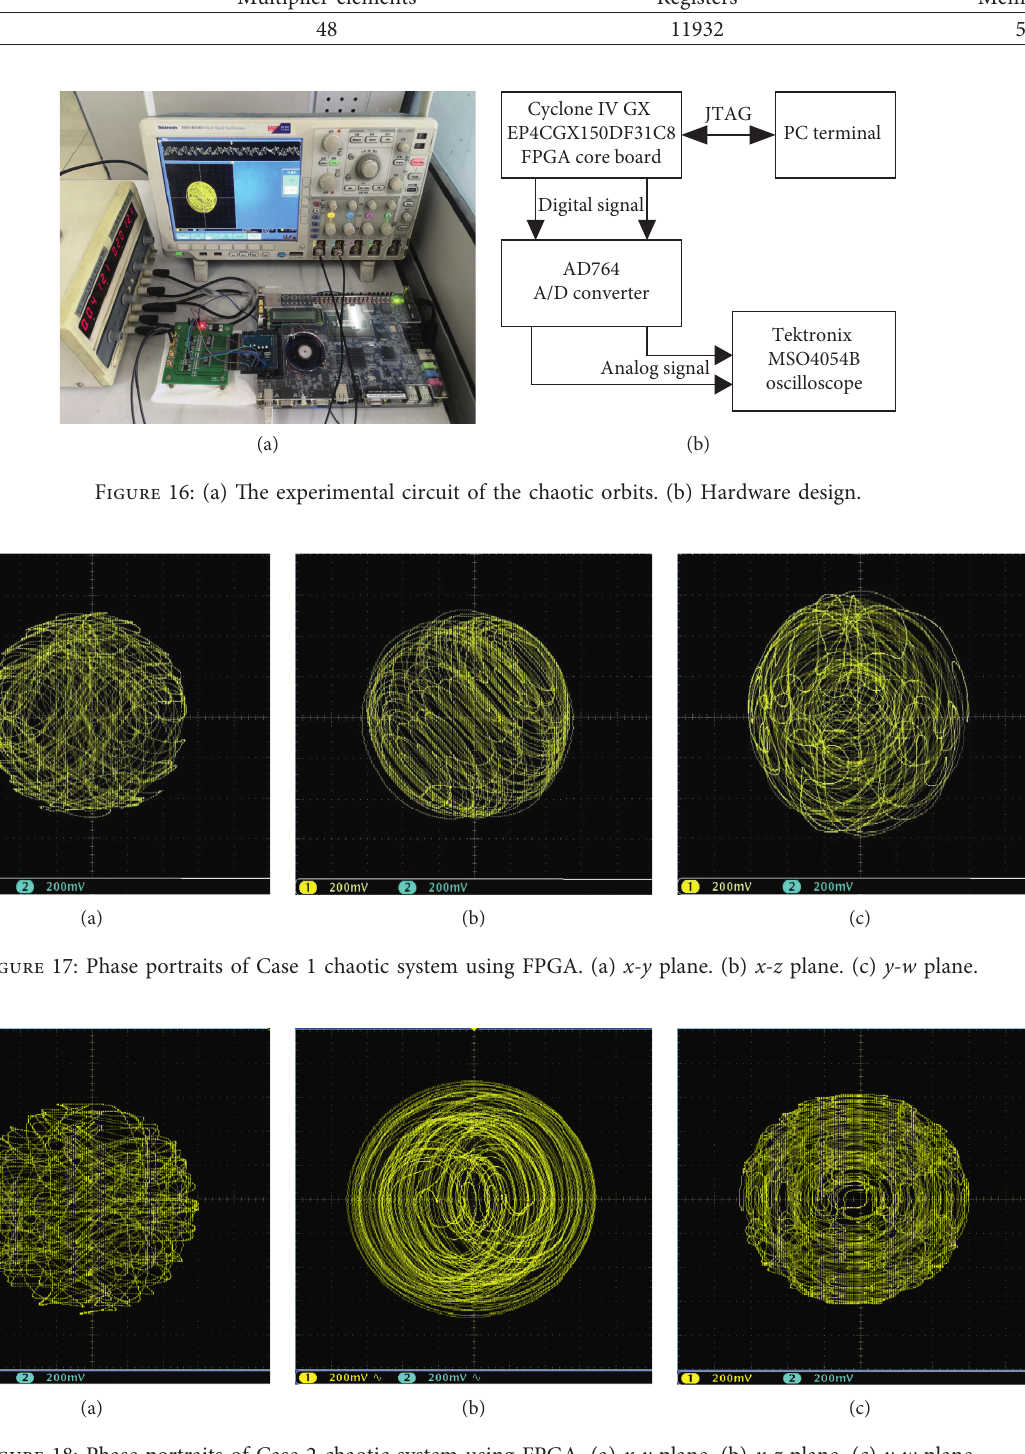
Figure 18: Phase portraits of Case 2 chaotic system using FPGA. (a) x-y plane. (b) x-z plane. (c) y-w